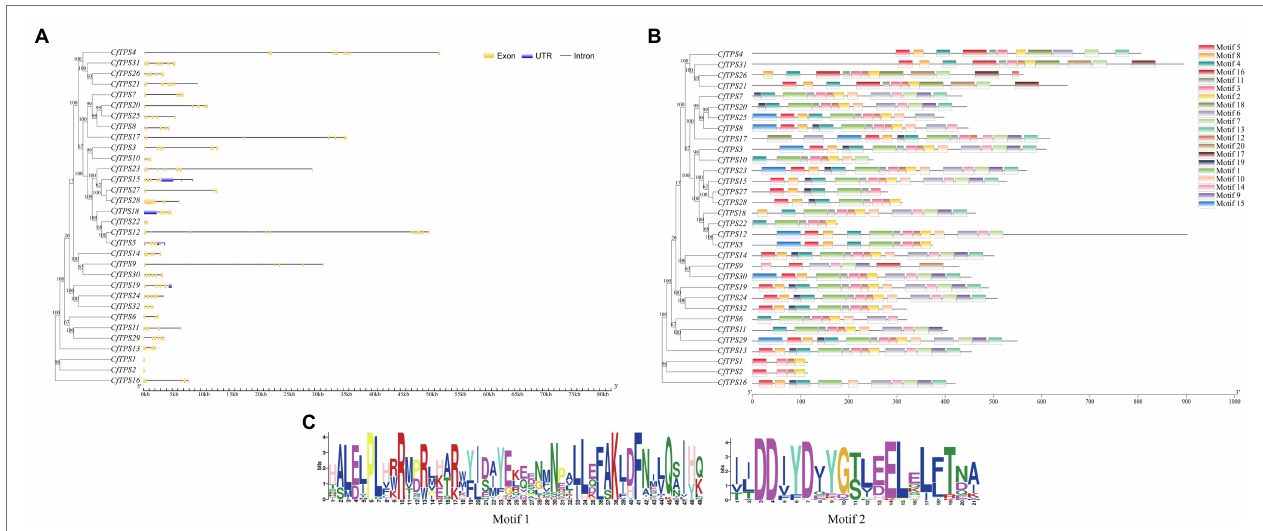
FIGURE 2 | Phylogenetic tree and intron-exon structure of CfTPS genes. (A) Phylogenetic tree and intron-exon structure of CfTPS genes. The maximum likelihood (ML) method was used for the phylogenetic tree, which was constructed with RAxML on the CIPRES Science Gateway web server (RAxML-HPC2 on XSEDE; Miller et al., 2011). Bootstrap values were 1,000 replicates with the JTT model. The intron-exon structure was drawn by the GSDS website (Hu et al., 2015). Yellow boxes, blue boxes, and black lines exhibit exons, introns, and upstream or downstream-untranslated regions. (B) Phylogenetic tree and conserved motifs of CfTPS genes. Conserved motifs were determined by MEME software with default parameters (Kaundal et al., 2010). (C) Sequence logo of motif 1 (RRX 8 W) and motif 2 (DDxxD). Motif 1 shows the N-terminal motif RRX 8 W, and motif 2 shows the C-terminal motif DDxxD motif. Conserved motifs are available in Supplementary Table S6